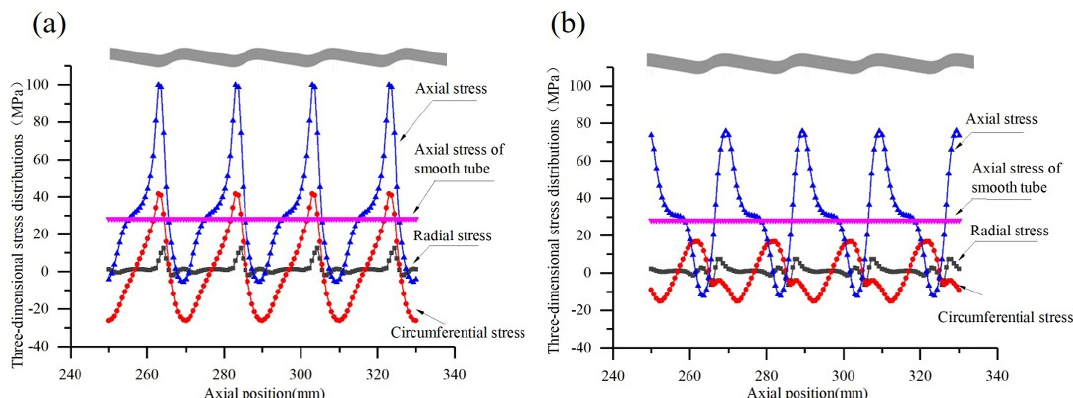
Figure 7. Stress distributions along tube length of conically corrugated tube: ( a ) on the outer surface; ( b ) on the inner surface ( D = 25 mm, S = 20 mm, t = 2.5 mm, e = 2.5, R 1 = 5, R 2 = 6, F = 5000 N). The experiments revealed that the axial stiffness of the conically corrugated tube reduced to a certain extent compared with the smooth tube. Therefore, as with the stress concentration factor R ZC , the stiffness equivalent coefficient K fC is defined as the ratio of the axial stiffness of the conically corrugated tube over the axial stiffness of the conically corrugated tube. Similarly, it can be fitted to the function of dimensionless parameters ( e , S and t ): D D D